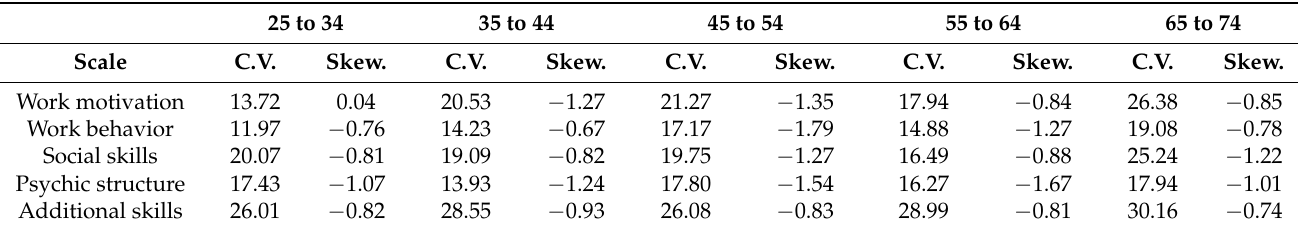
Table 8. Coefficients of variation (C.V., measured in percent) and skewness (Skew.) of the overall answers of the different scales of the questionnaire when the sample is differentiated by age range.